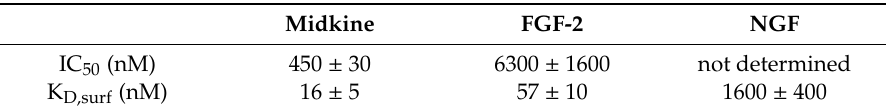
Table 1. IC 50 and K D,surf values for the interaction between fluorinated sugar 17 and midkine, basic fibroblast growth factor (FGF-2) and nerve growth factor (NGF) proteins. The IC 50 values were obtained from solution fluorescence polarization (FP) competition experiments while the K D,surf values were calculated from assays using fluorous sugar-coated microplates.